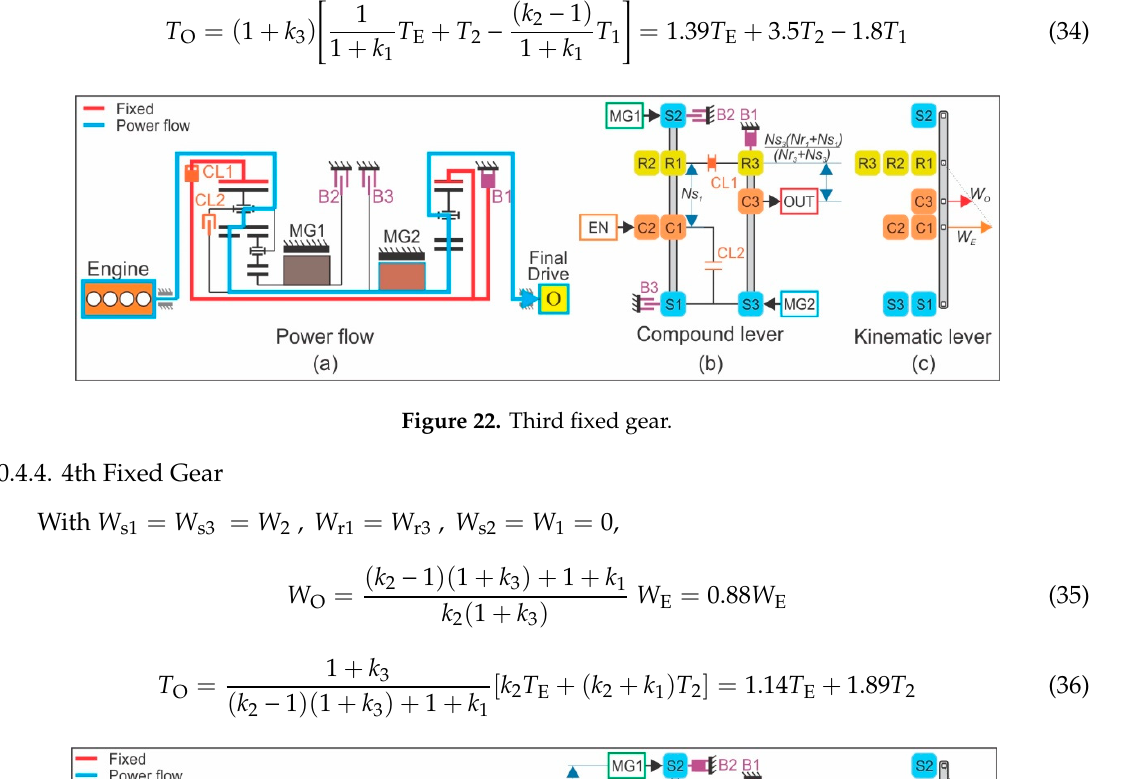
(32) Figure 21. Second fixed gear.